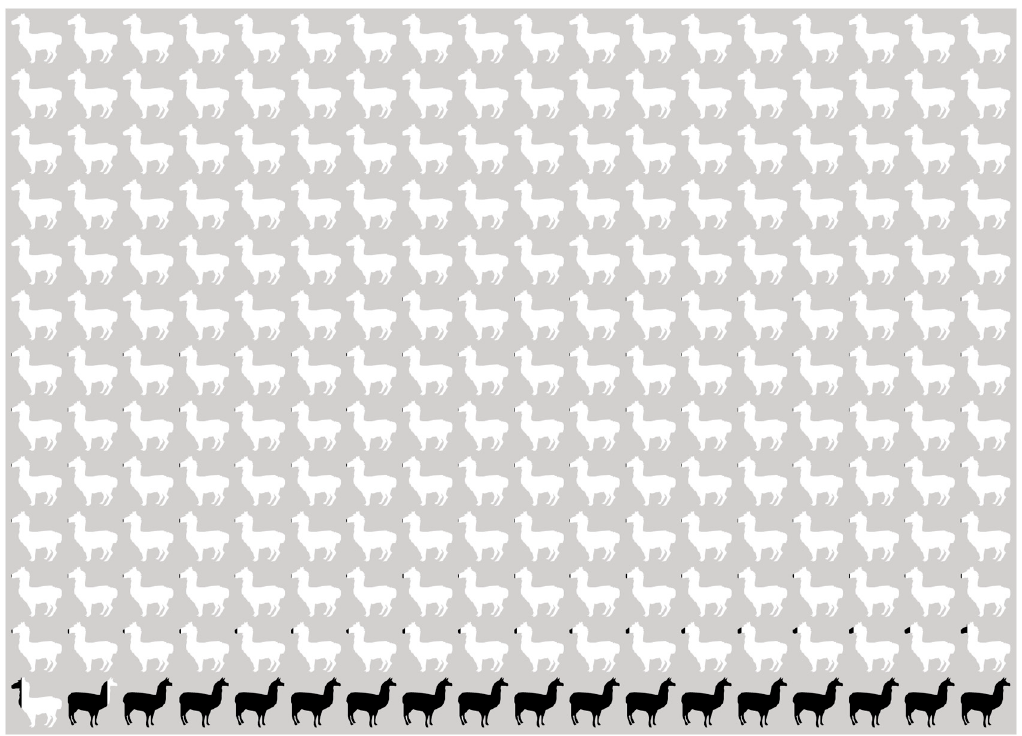
Figure 2. Percentage of individual membership in all tested animals, based on coefficient value ( q ). Alpaca: white color, llama: black color.